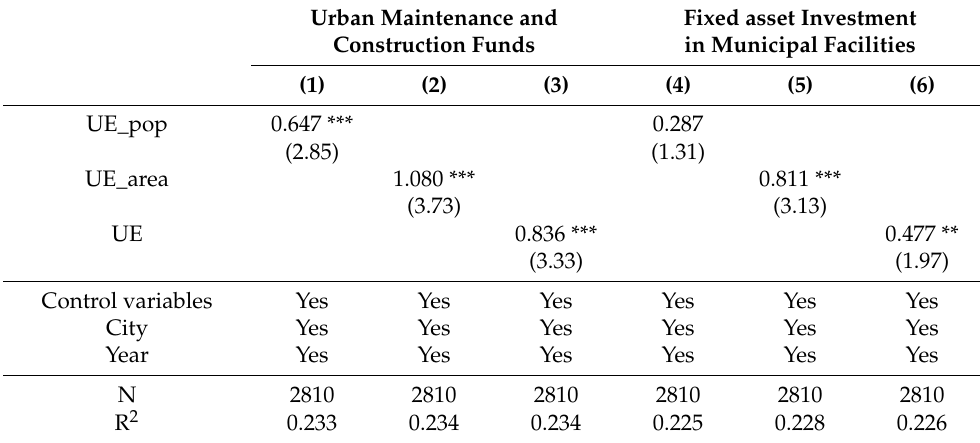
Table 9. Regression results of urban construction and maintenance